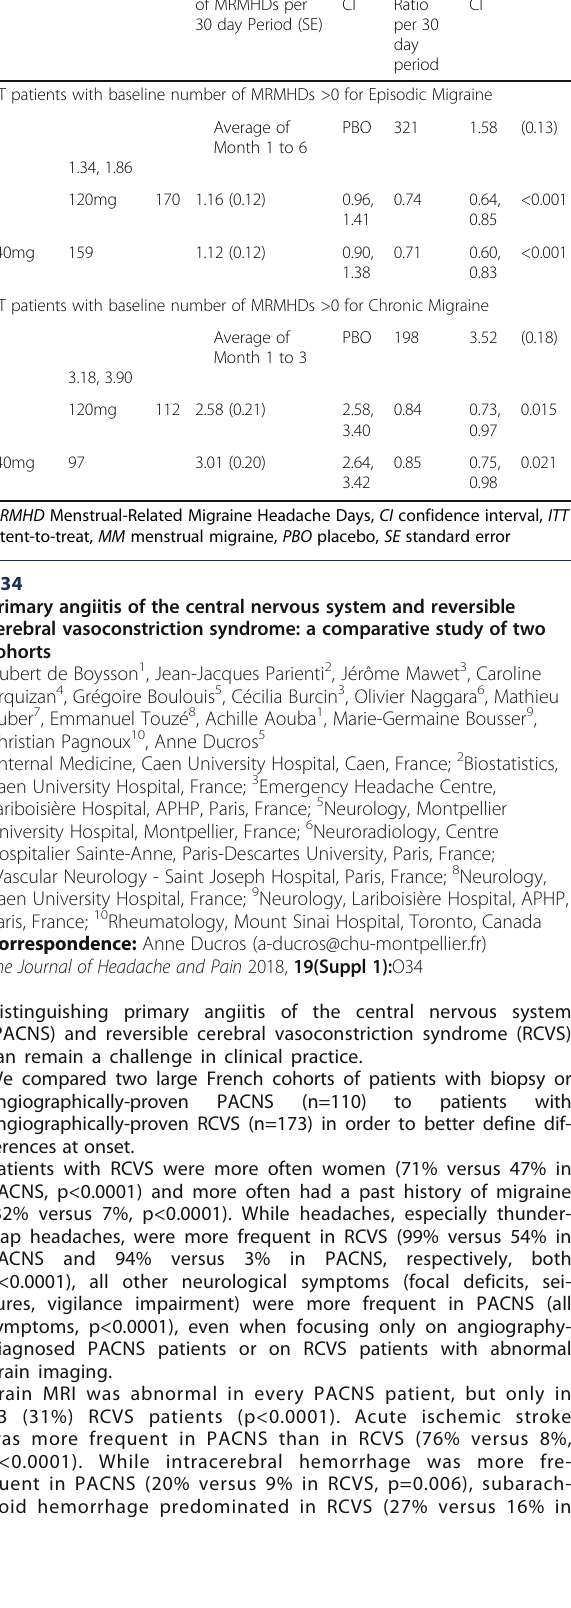
Table 1 (abstract O33). Estimated Number of Menstrual-Related Migraine Headache Days Period Treatment N Estimated Number of MRMHDs